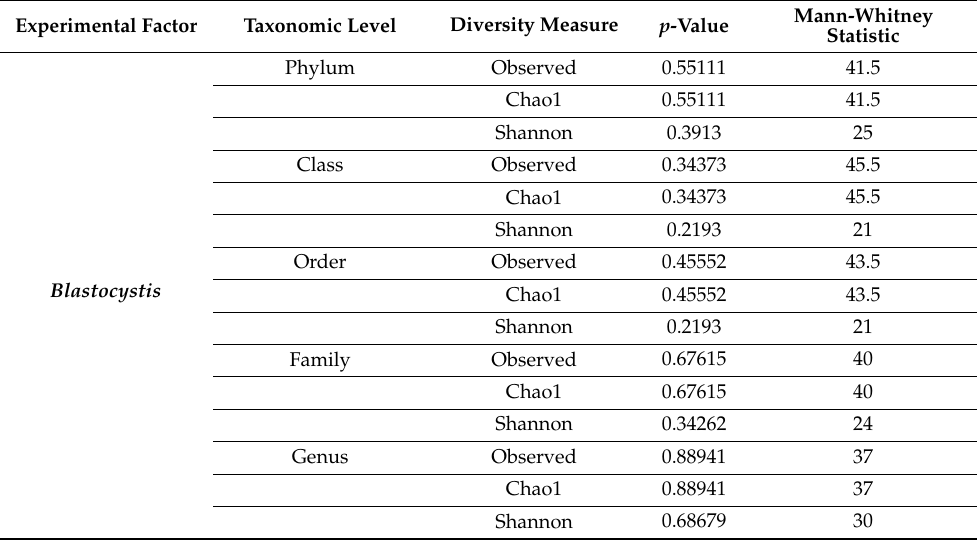
Table A3. Alpha diversity results for Blastocystis positive ( B+ ) voles compared with negative ( B- ) voles. Diversity was measured using three methods: Observed, Chao1 and Shannon indices at each taxonomic level. No statistically significant results were identified ( p < 0.05).